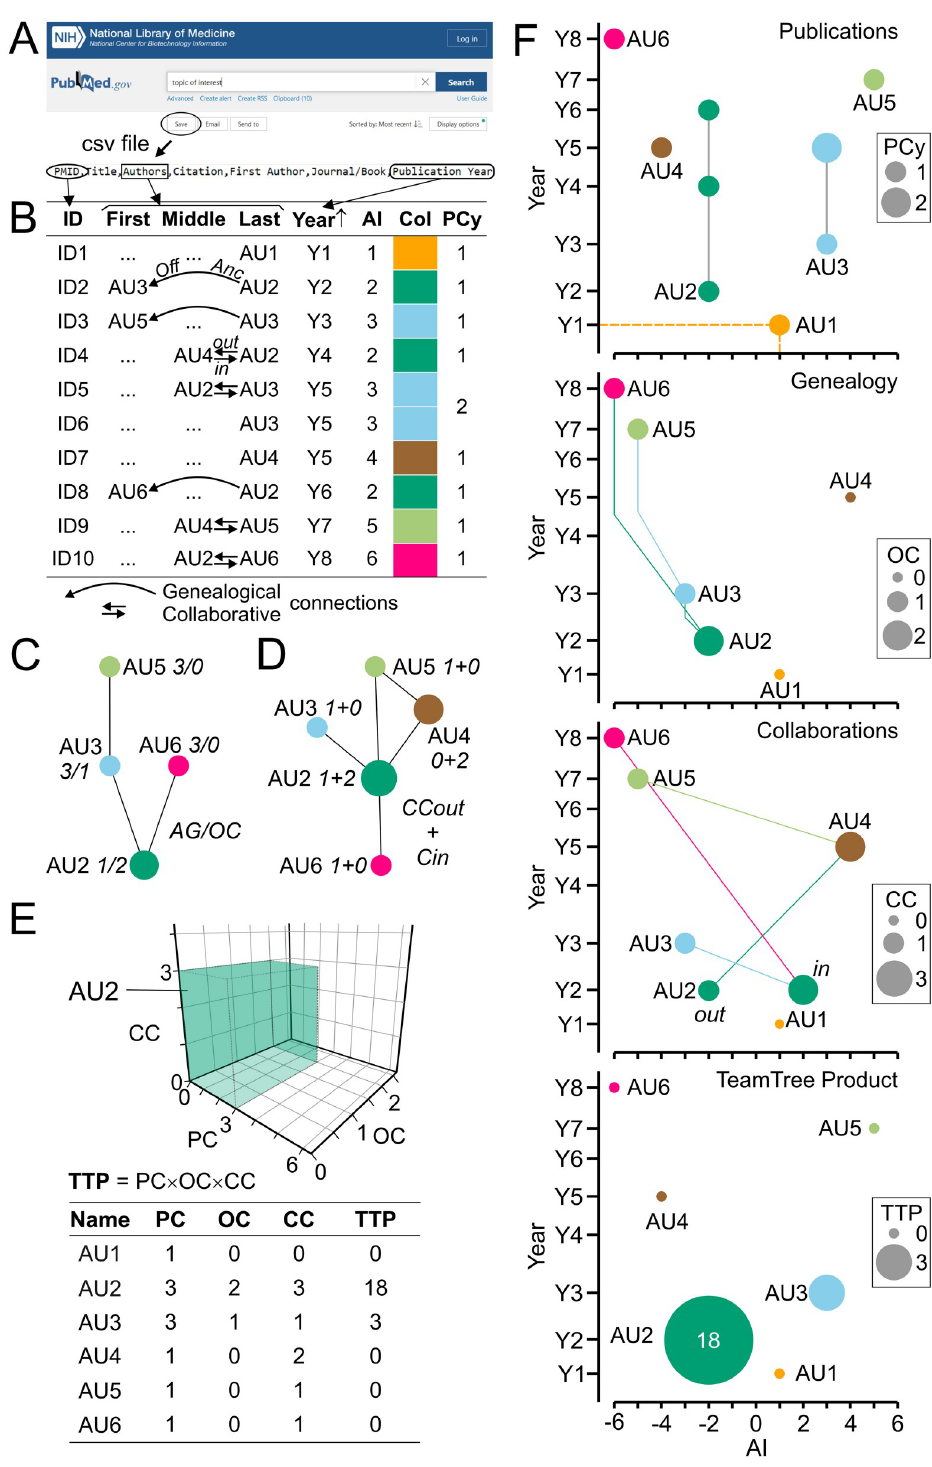
Fig 1. Principal steps and key features of TeamTree analysis. (A) Screenshots of the PubMed website and of a comma-separated values (csv) file illustrating a query in the bibliographic database MEDLINE, the download of scientific articles and the extraction of data required by TTA. (B) Table showing generic articles with identifiers (ID), authors separated by byline position (First, Middle, Last), and years of publication. Only authors mentioned at least once on the last byline position are taken into account and indicated by generic names (AUx). TTA sorts articles by